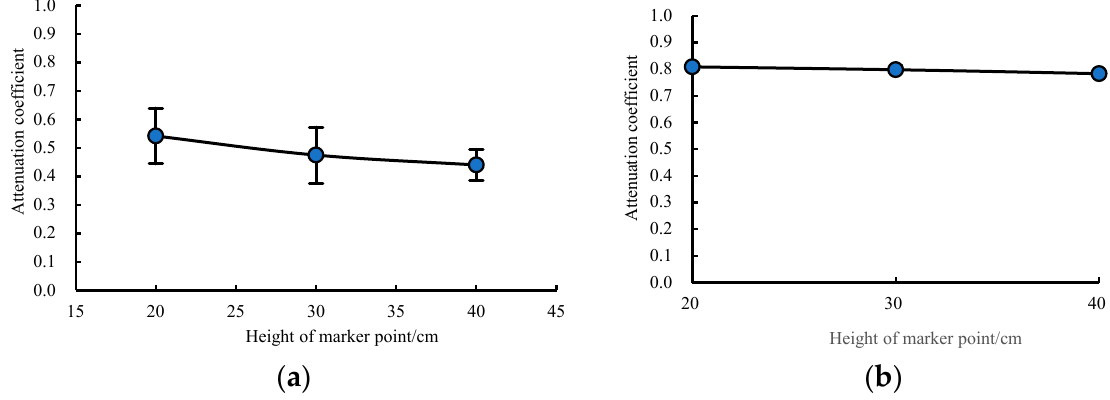
Figure 11. Attenuation coefficients at different mark points. ( a ) Lateral branch. ( b ) Main branch. The average attenuation coefficients at 20 cm, 30 cm, and 40 cm from the main branch node on the side branch were 0.542, 0.475, and 0.441, respectively, as shown in Figure 11a. The attenuation coefficient decreases with the distance between the marker point and